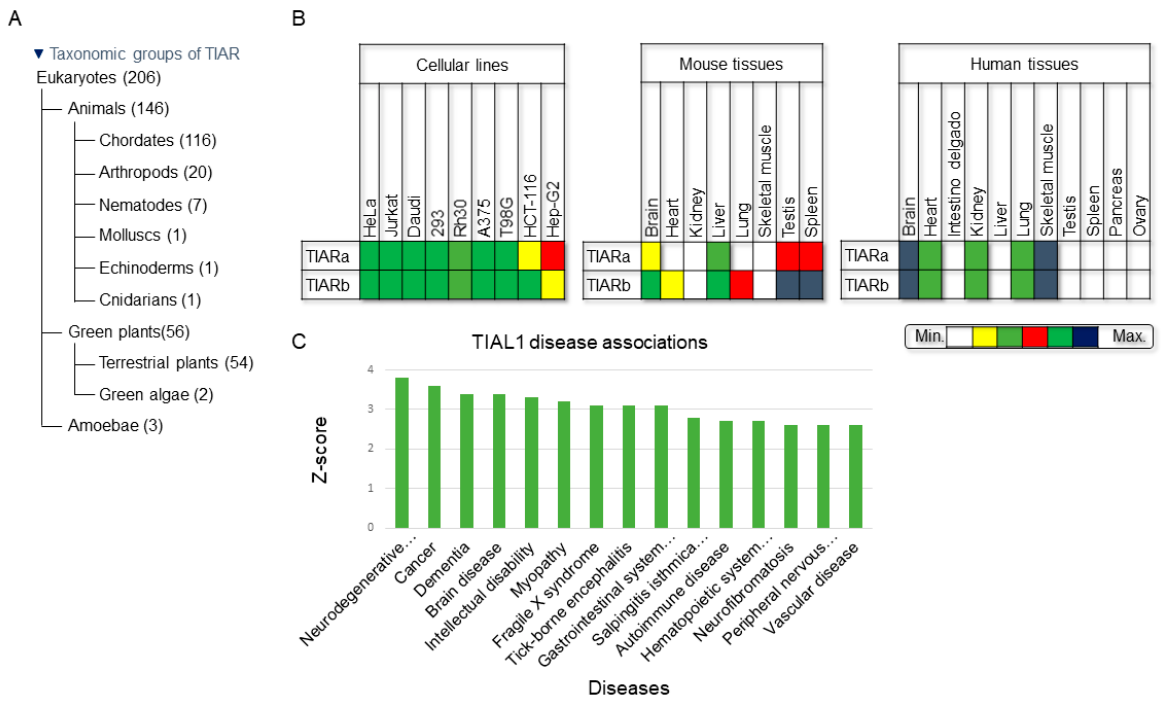
Figure 4. Phylogenetic graphics, cellular- and tissular-expression patterns and TIAR-associated diseases based on the Jensen Laboratory list. ( A ) Taxonomic groups of TIAR according to the National Center for Biotechnology Information database. ( B ) Expression profiling of TIAR in human cell lines and in human and mouse tissues. HeLa (uterine carcinoma), Jurkat (T lym- phoma), Daudi (B lymphoma), HEK293 (human embryonic kidney), Rh30 (bone marrow rhab- domyosarcoma), A375 (melanoma), T98G (glioblastoma), HCT-116 (colon carcinoma) and Hep-G2 (liver carcinoma). ( C ) Gene ontology of human diseases associated with TIAL1/TIAR (identifier: (ENSP00000358089)) expression, according to Jensen’s list, derived from automatic text mining of the biomedical literature, database annotations, cancer mutation data and genome-wide association stud- ies (https://diseases.jensenlab.org/Entity?order=textmining,knowledge,experiments&textmining= 10&knowledge=10&experiments=10&type1=9606&type2=-26&id1=ENSP00000358089, last access on 25 June